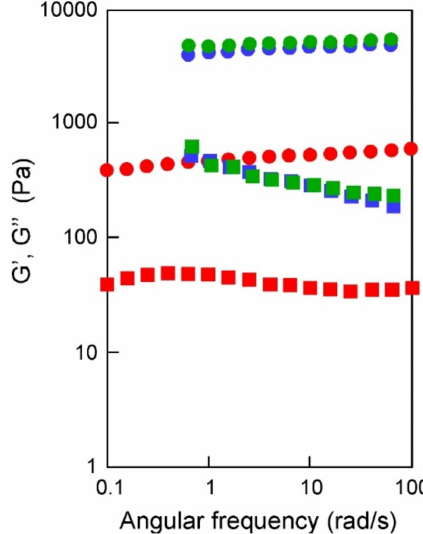
Figure 8. Angular frequency dependence (rad/s) of storage modulus G’ (circles) and loss modulus G” (squares) of silver nanocomposite hydrogels PHE-Nip-EBA (red), PHE-Nip-PEG (blue), and AVA-Nip-PEG (green). Strain 0.1%, 25 ◦